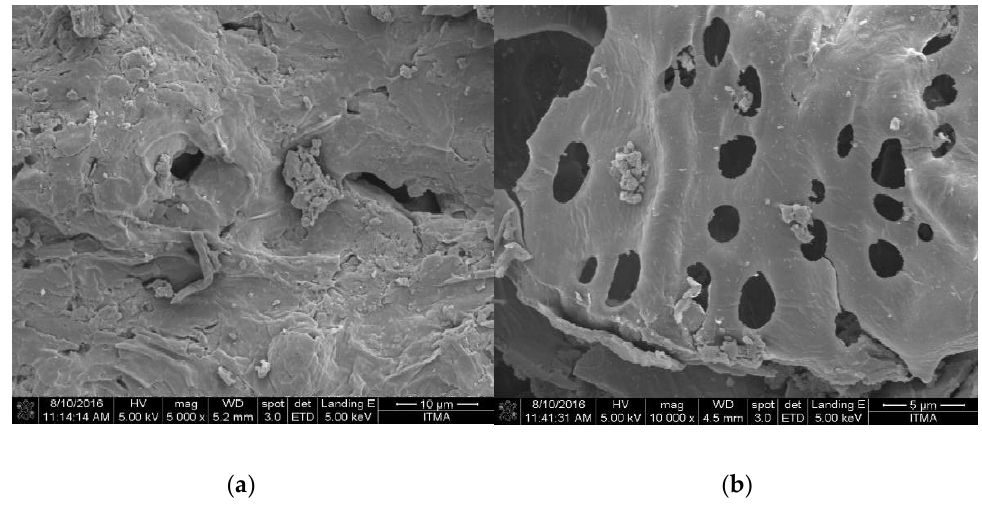
Figure 2. Field emission scanning electron microscopy images (FESEM) images of ( a ) TW-Char (5000×); ( b ) STW catalyst (10,000×).